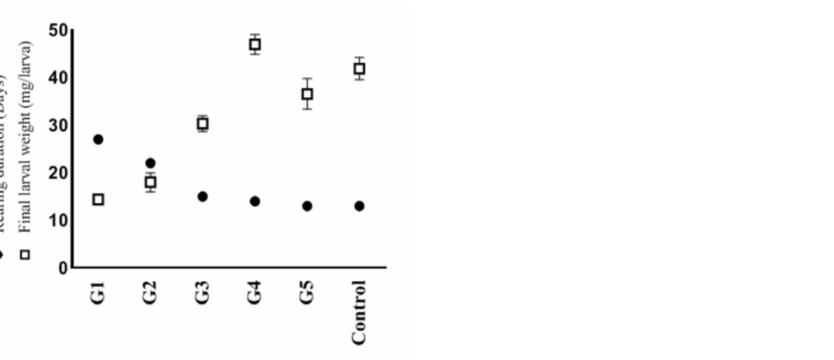
Figure 2. Effect of different ratios of blended sewage sludge on larval rearing durations and final black soldier fly larvae (BSFL)